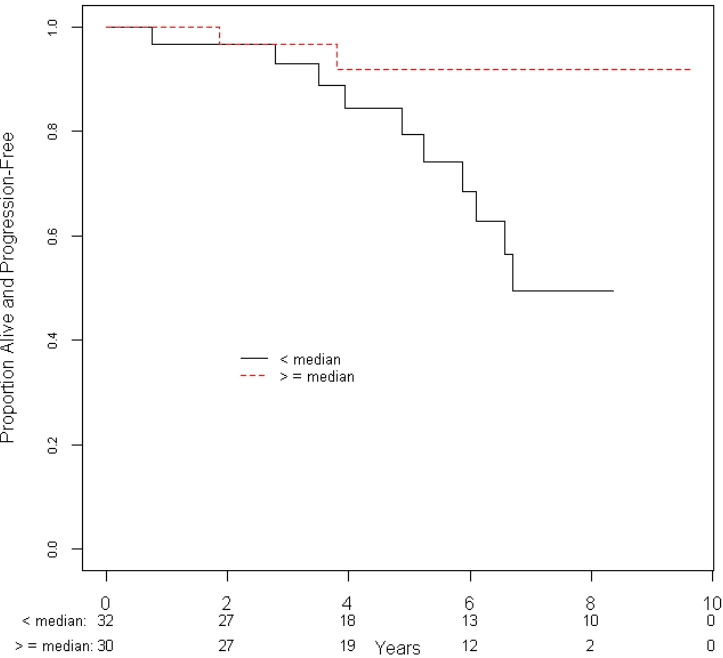
Figure 2. Progression-free survival of patients based on the conformity index in relation to the median values of the cohort. Table 3. Prognostic factors of radiographic progression-free survival using a Cox proportional haz- ards regression.